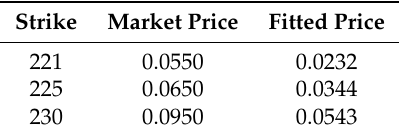
Table 1. Sample of Fitted OTM Put Option Prices for SPY on 27 December 2017 for a maturity of 23 days with the spot price at